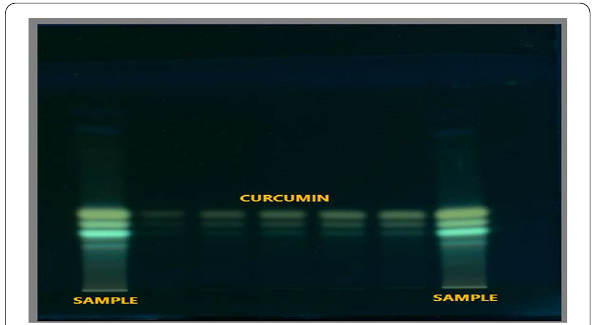
Fig. 4 HPTLC profiling of C. longa methanolic fraction with